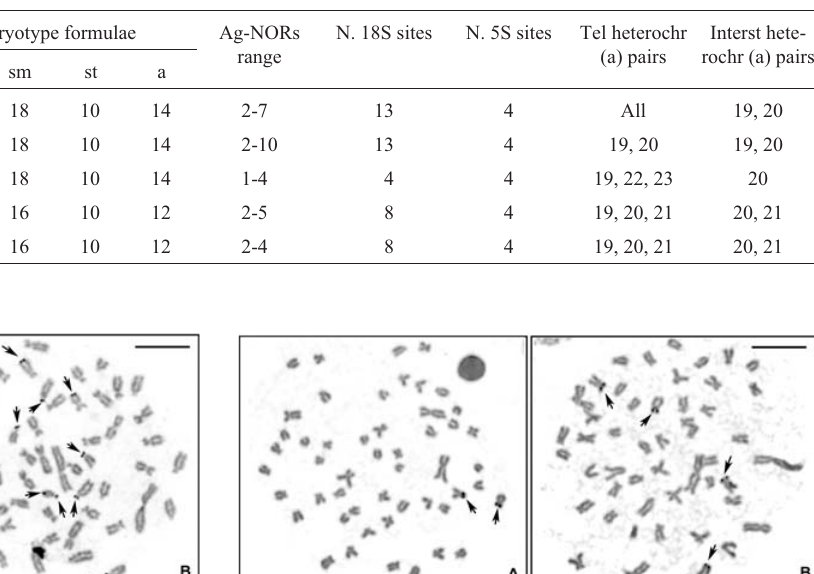
Table 2 - Karyotype data of Astyanax from the Verde River (Tibagi basin), Açungui River (Ribeira basin), Santo Antônio River (Jaguariaíva basin), and Jaguariaíva River. Kar = karyotypes; Tel heterochr (a) pairs = telomeric heterochromatin in acrocentric pairs; Interst heterochr (a) pairs = interstitial heterochromatin in acrocentric pairs.